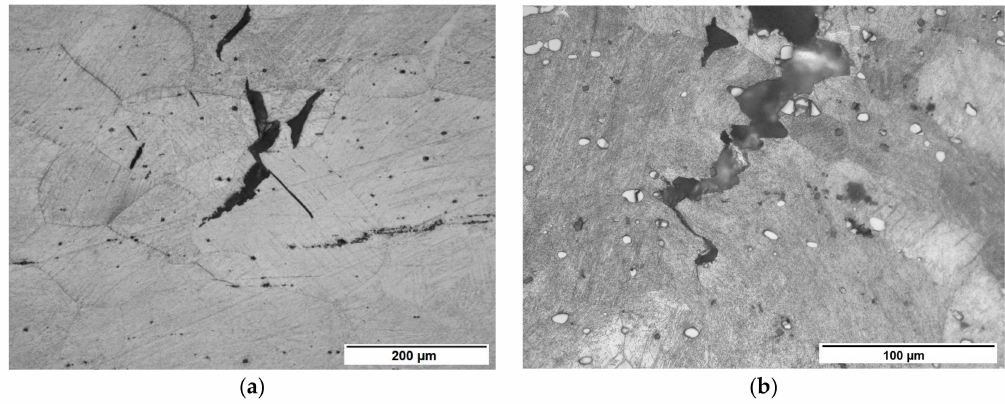
Figure 9. Micrographs of crack propagation (crack tip) under bending in precipitation hardened alloys: ( a ) Mg10Gd and ( b )